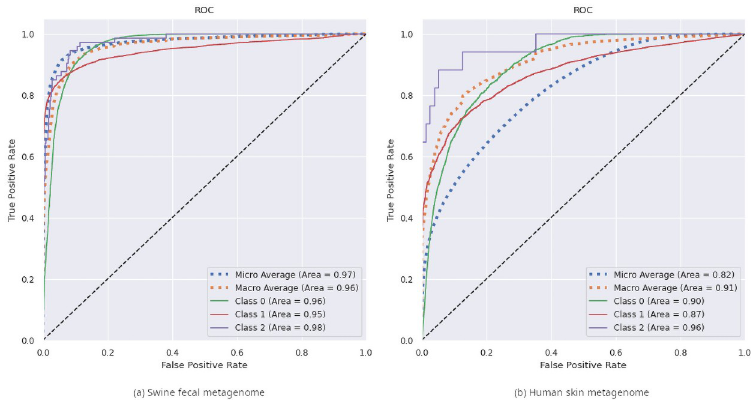
Fig 4. Prediction results of the complete classification pipeline on data from real metagenomic sequencing studies. ROC curves for taxonomic classification in swine feces metagenome (A) and human skin metagenome (B) datasets. The classes are as follows: 0—viral, 1—bacterial, 2—mammalian.